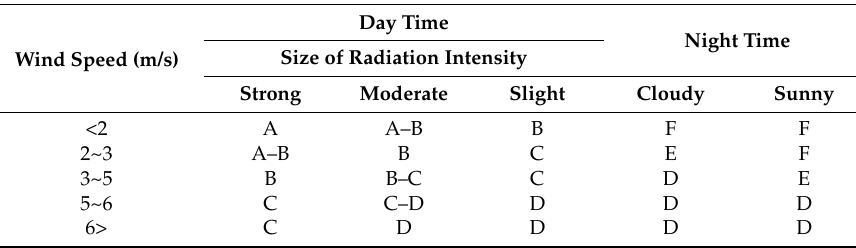
Table 6. Meteorological stability for Pasquill’s classes.